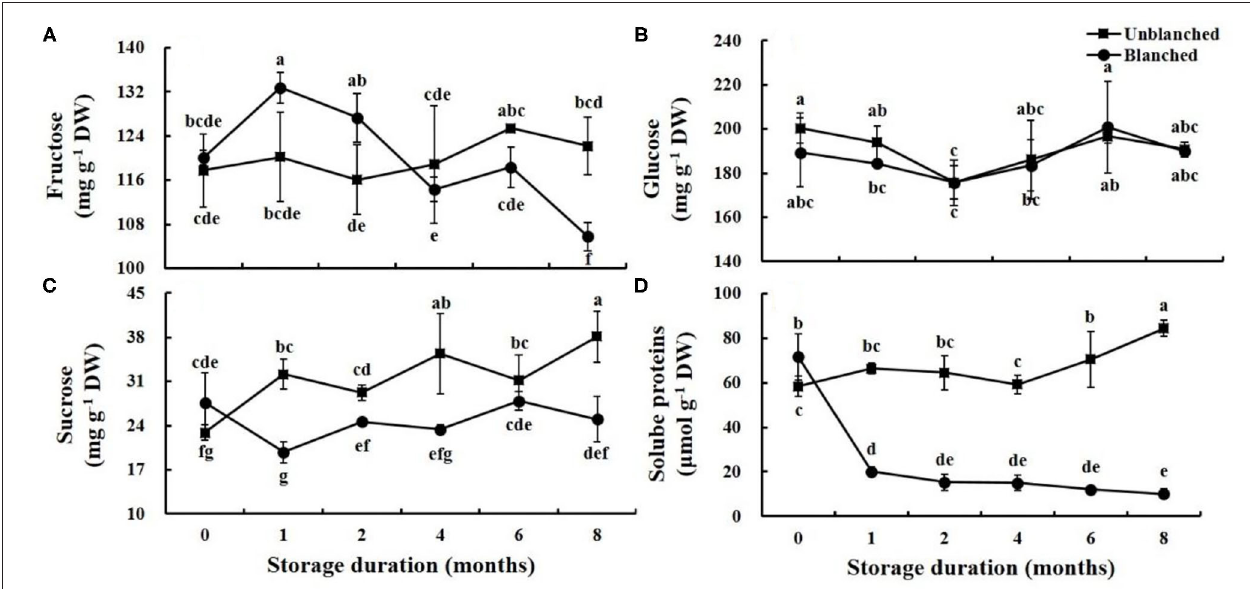
FIGURE 5 | Evolution trend of soluble sugars and soluble proteins contents in baby mustard lateral buds during frozen storage at − 20 ◦ C. (A) fructose; (B) glucose; (C) sucrose; (D) soluble proteins. Unblanched represents no blanching before freezing; Blanched represents blanching before freezing. Values not sharing the same letter are significantly different at p < 0.05.